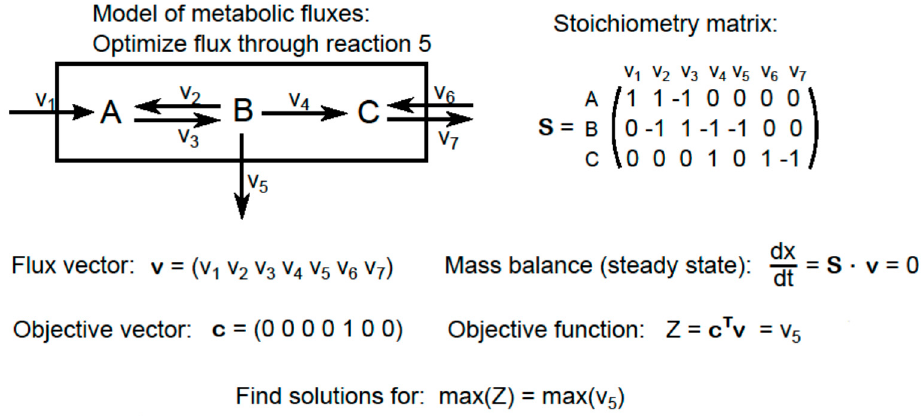
Figure 3. Example of a simple metabolic flux model and the equations for defining a flux balance analysis to maximize flux through reaction 5.